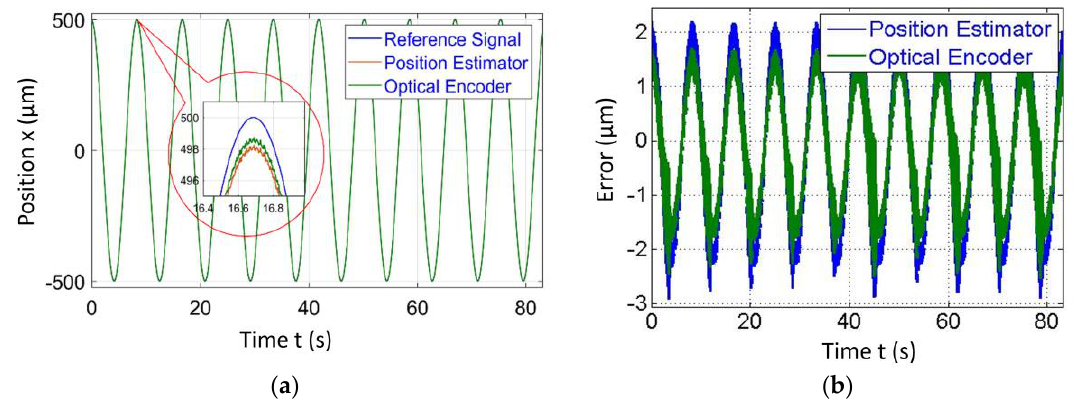
Figure 18. Position estimator output for amplitude = 500 µm and frequency = 0.15 Hz at a scanning speed = 1.5 mm/s.